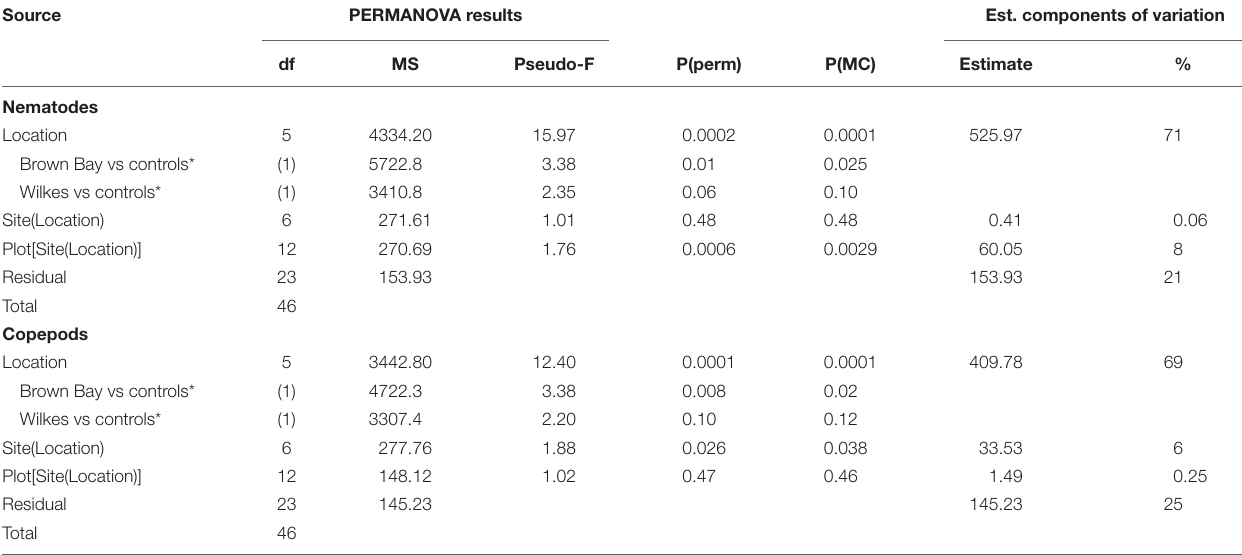
TABLE 2 | Results of PERMANOVA analyses for nematode and copepod communities at Casey Station, with estimated components of variation (ECV) derived from